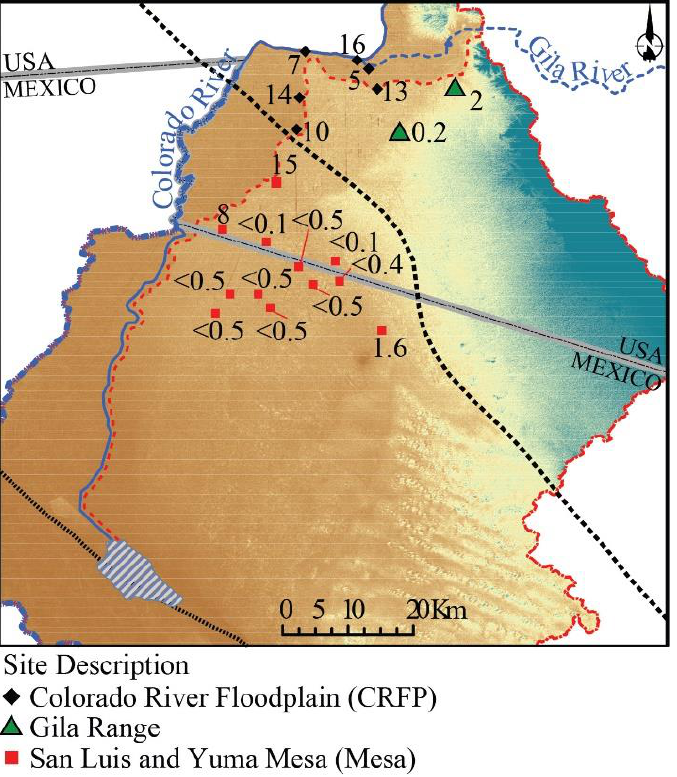
Figure 9. Tritium (TU) data for groundwater samples. Shading indicates topography (see Figure 1). The red-dotted line indicates the extent of the San Luis and Yuma Mesa.